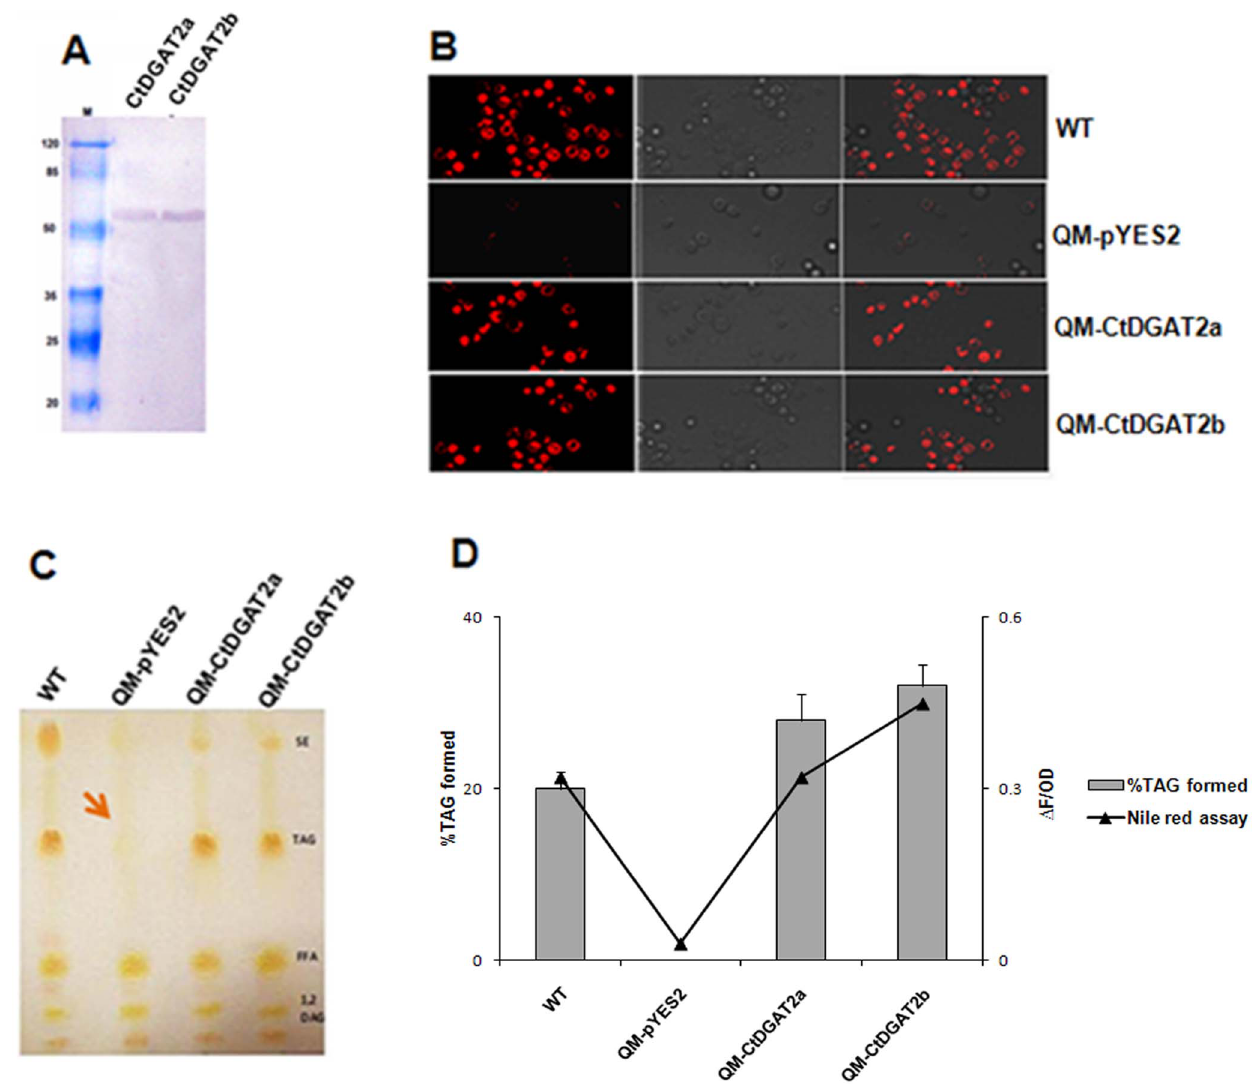
Figure 4. Both CtDGAT2a and CtDGAT2b are functionally active to produce TAG in S.cerevisiae QM strain, and the CtDGAT2b is catalytically more active. (A) Western blot showing the recombinant protein of , 63 kDa produced upon galactose induction of yeast QM cells transformed with the full length CtDGAT2a or CtDGAT2b gene expression cassette prepared in pYES2/CT plasmid. Immunodetection was carried out with mouse anti-His monoclonal antibody. (B) Nile red fluorescence confocal microscopy showing lipid body formation is restored in yeast QM cells upon expression of either CtDGAT2a (QM-CtDGAT2a) or CtDGAT2b (QM-CtDGAT2b). The yeast wild-type BY742 cells were used as positive control (WT), and the QM cells harboring the non-recombinant plasmid was used as negative control (QM-pYES2). (C) Complementation of the TAG-deficient phenotype of the yeast QM strain by expression of either CtDGAT2a or CtDGAT2b. Neutral lipid fractions were separated by TLC, and lipid spots were visualized as described in experimental methods. (D) Bar and line diagrams representing gravimetric measurement and Nile red fluorescence assay of lipid content in QM cells after expression of the full length CtDGAT2a and CtDGAT2b, along with the WT and QM cells transformed with the non- recombinant plasmid as positive and negative controls, respectively. Fluorescence was measured at the stationary phase using 485nm (excitation) and 540nm (emission) before and after the addition of Nile red dye, and expressed in arbitrary unit.